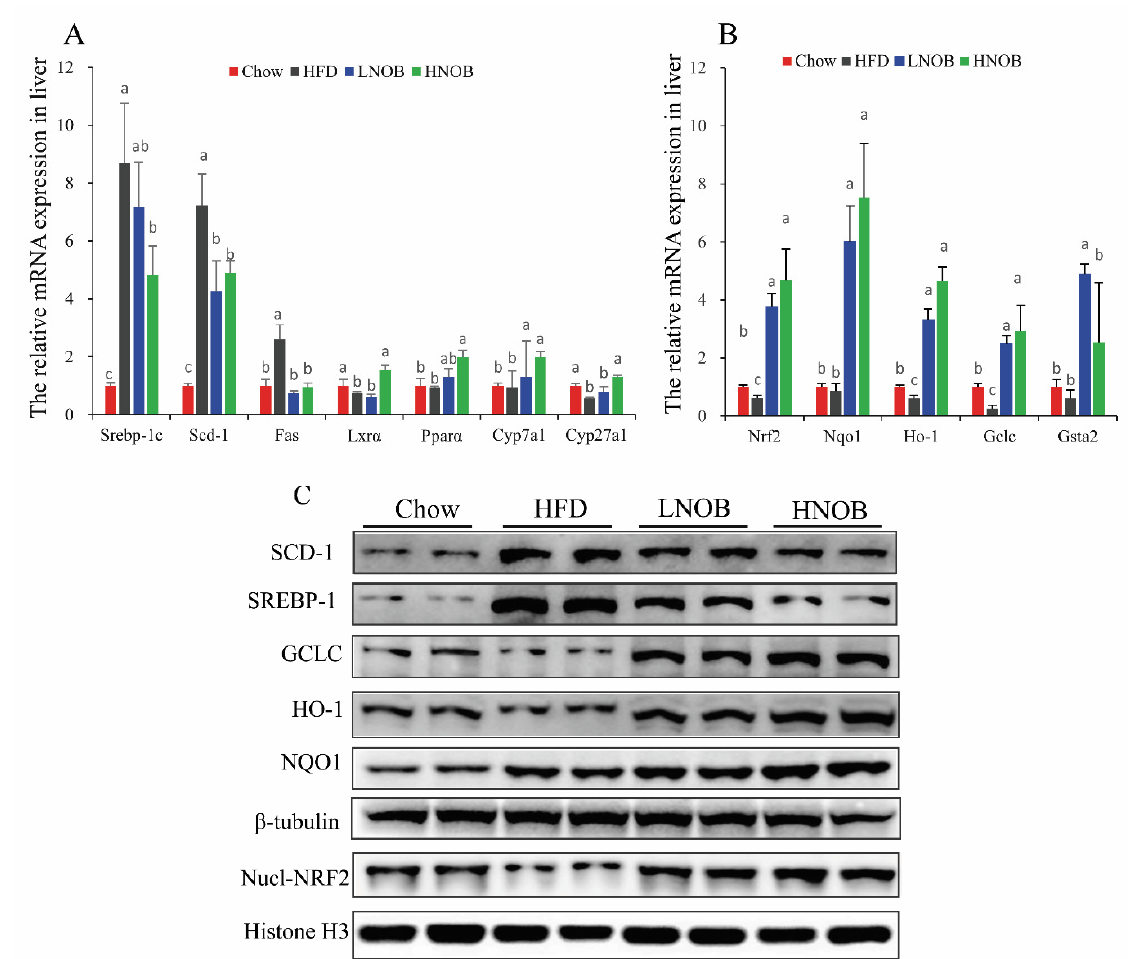
Figure 6. The effects of NOB supplementation on the expression of lipid metabolism and Nrf2 ‐ pathway ‐ related factors in HFD ‐ induced mice. The mRNA expression of hepatic lipid metabolism genes ( A ) and anti ‐ oxidation genes ( B ). Data are shown as the mean ± SD ( n = 4). Data with different letters (a, b, c) represent significant differences ( p < 0.05), whereas bars with the same letter correspond to values that exhibit no significant differences. In the case where two letters are present on top of the bars in A, each letter should be compared separately with the letters of other bars to determine whether the values show significant differences. ( C ) Representative immunoblots for SCD ‐ 1, SREBP ‐ 1, GCLC, HO ‐ 1, NQO1, β‐ tubulin, Nucl ‐ NRF2, and Histone ‐ H3.